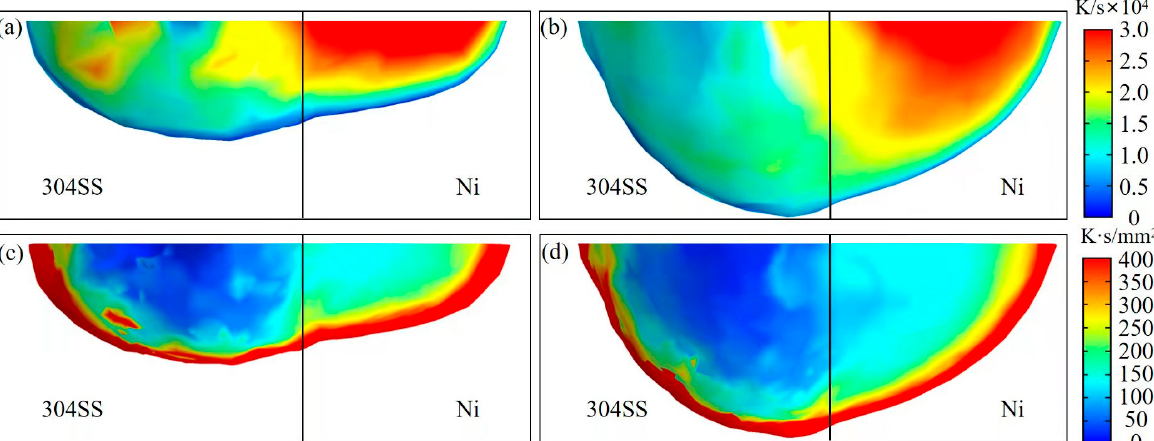
Figure 7. Distribution of GR and G/R in the molten pool in laser welding. ( a ) Cooling rate GR in pure argon; ( b ) cooling rate GR in the AMO; ( c ) morphology parameter G/R in pure argon; and ( d ) morphology parameter G/R in the AMO.